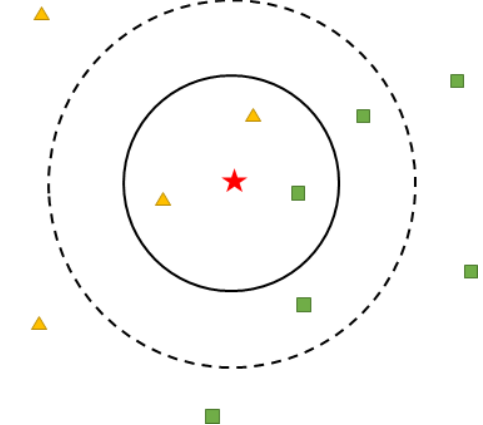
Figure 5. Illustration of a typical KNN